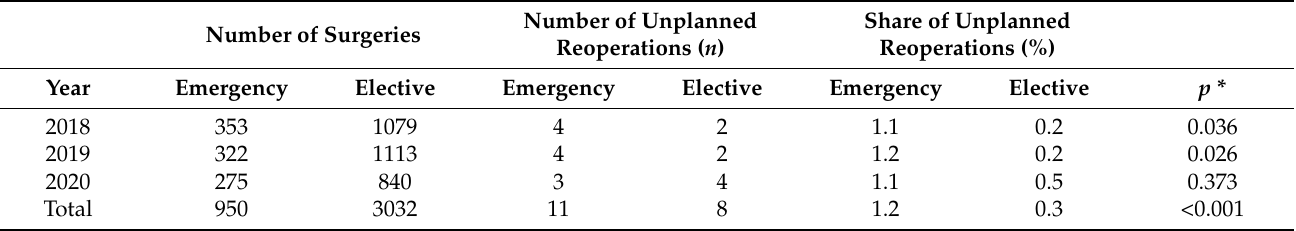
Table 2. Distribution of patients based on the type of primary surgery (elective/emergency) for each individual year. Type of